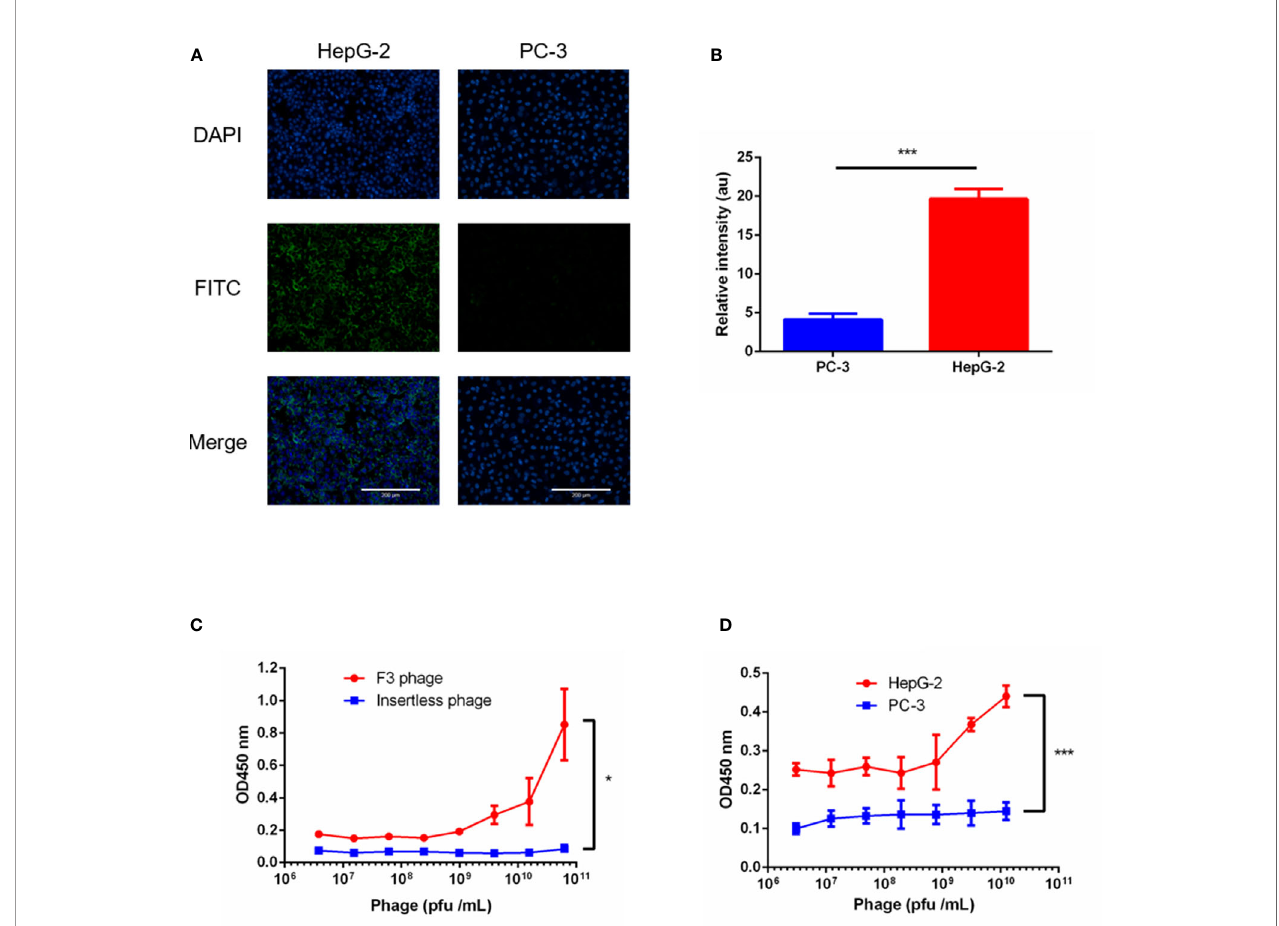
FIGURE 2 | ELISA tests of phage clone F3 binding to GPC-3. (A) Immuno fl uorescence staining of GPC-3 expressed in the HepG-2 and PC-3 cell lines. Strong fl uorescence was observed in HepG-2 cells, while barely signals were detected in PC3 cells as visualized by the anit-GPC-3 primary antibody and FITC-conjugated secondary antibody (green). Nuclei were stained with DAPI (blue). Scale bars: 200 µm. (B) Fluorescence signal of FITC in the PC-3 and HepG-2 cells was analyzed by the Image J software (n = 5 per group, p = 0.0002, ***p < 0.001, two-tailed Student ’ s t-test). (C) The ELISA test performed between phage clones and the recombinant human GPC-3 protein. The F3 phage showed high af fi nity to the GPC-3 protein. No concentration dependent binding between the insertless phage and the GPC3 protein was observed (n = 4 per group, p = 0.0255, *p < 0.05, two-tailed Student ’ s t-test). (D) The ELISA test performed between the F3 phage and cell lines. Stronger binding of the F3 phage was found in HepG-2 panels instead of PC-3 panels (n = 4 per group, p = 0.0001, ***p < 0.001, two-tailed Student ’ s t-test). All data represent the means ± standard error. P-value was calculated by two-tailed Student ’ s